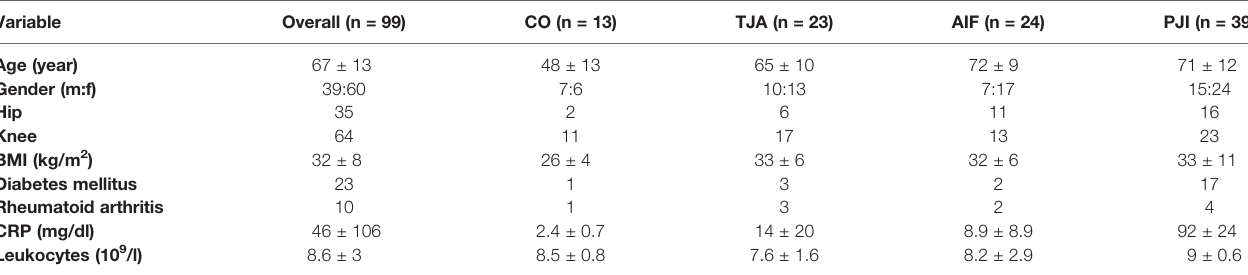
TABLE 1 | Patient characteristics (n =